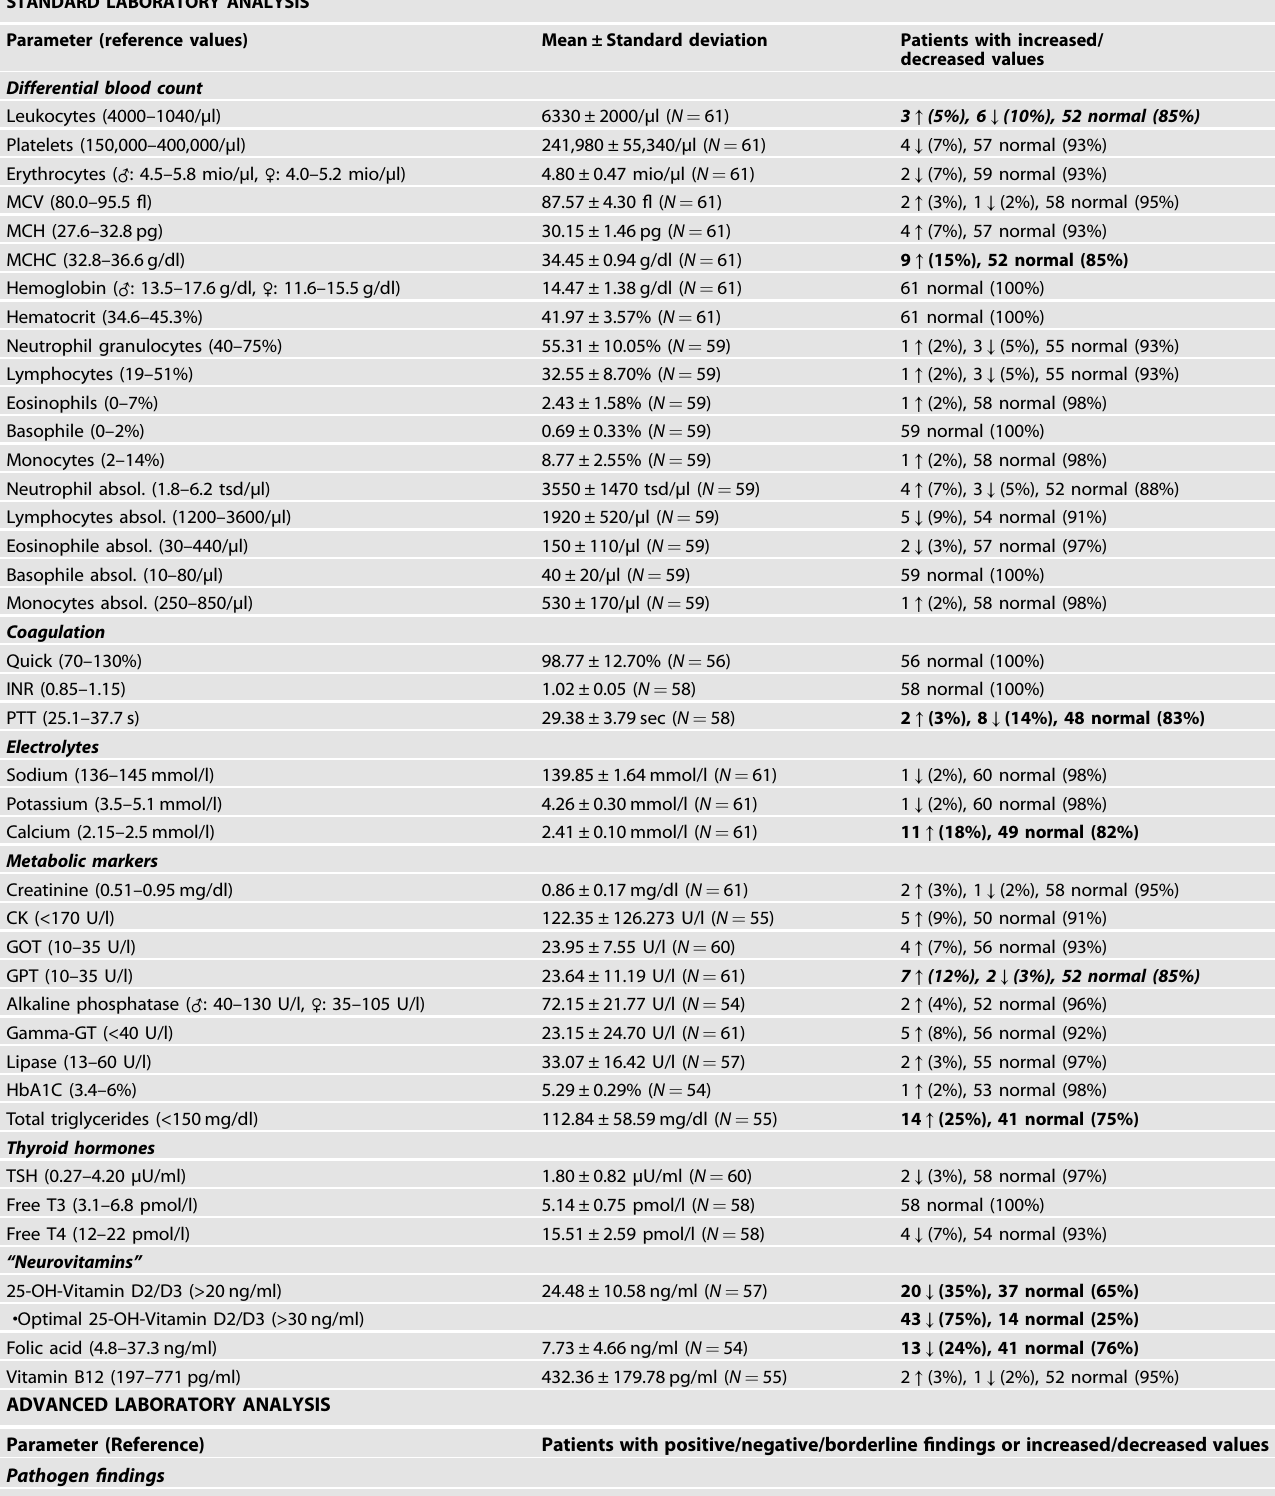
Table 3. Laboratory fi